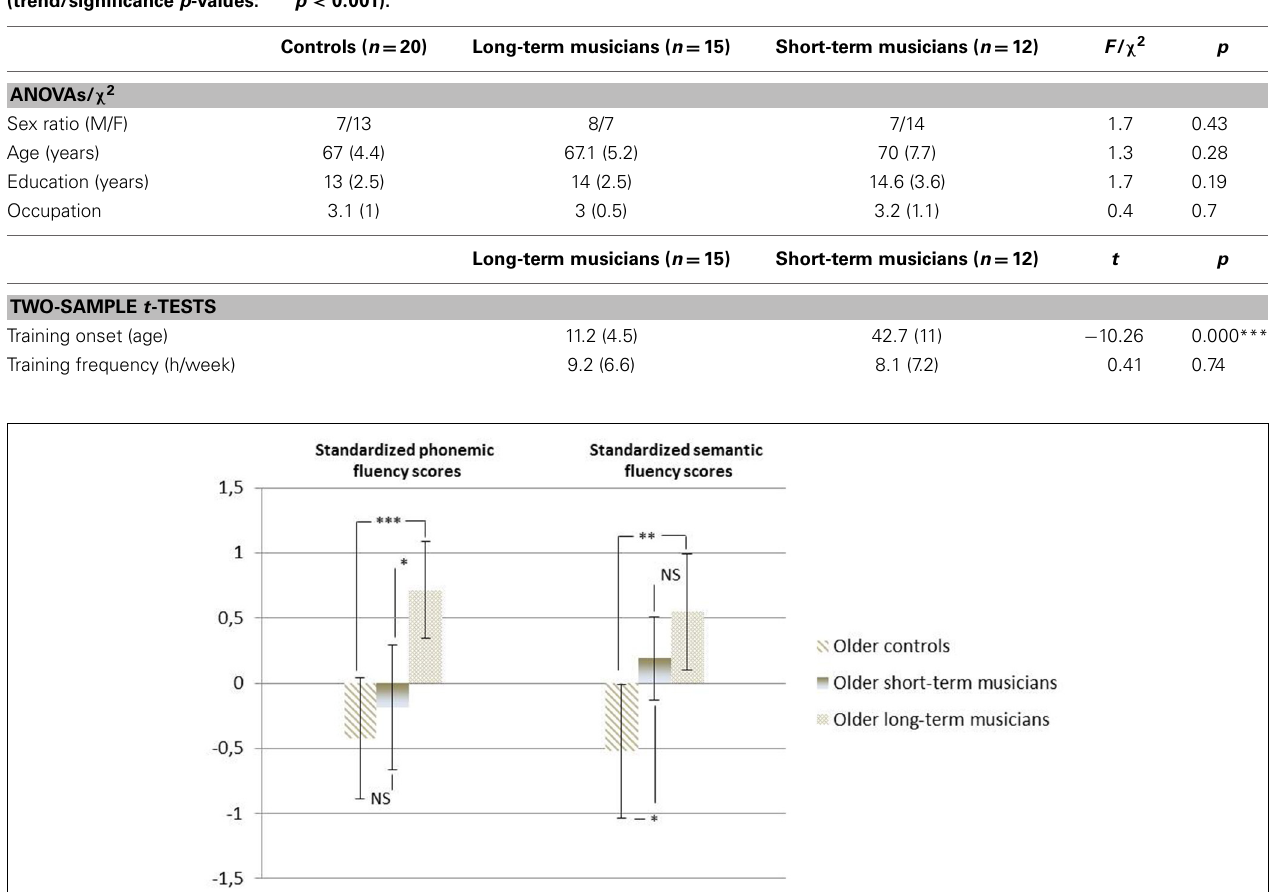
FIGURE 3 | Means and standard deviations of phonemic and semantic fluency z scores for older controls and older short- and long-term musicians ( ∗ p < 0 . 05; ∗∗ p < 0 . 01; ∗∗∗ p < 0 . 001).